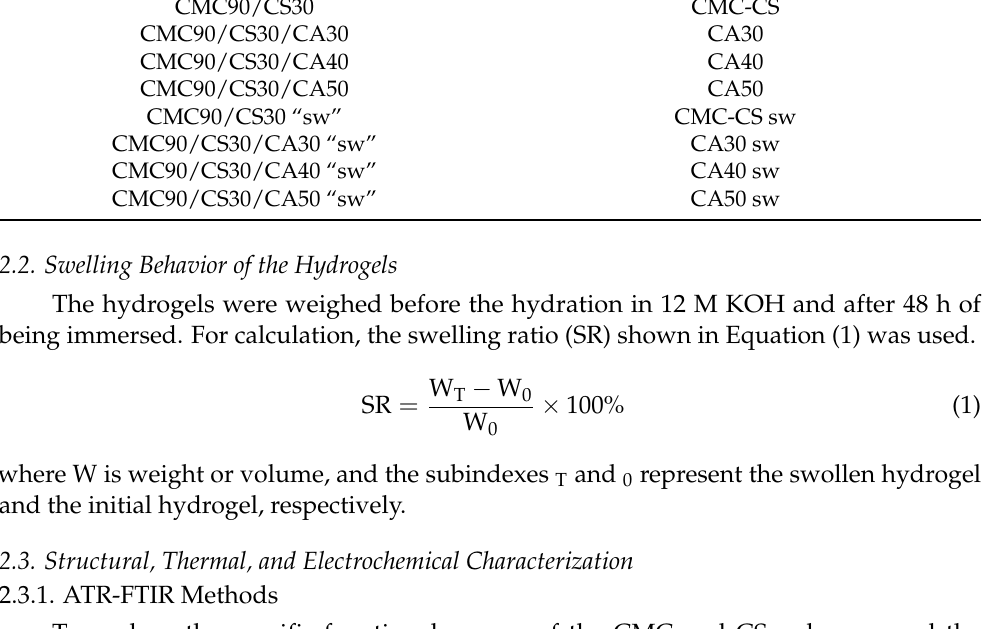
Table 1. Codes to name the hydrogel polymer electrolytes used in this work. Electrolyte Hydrogel